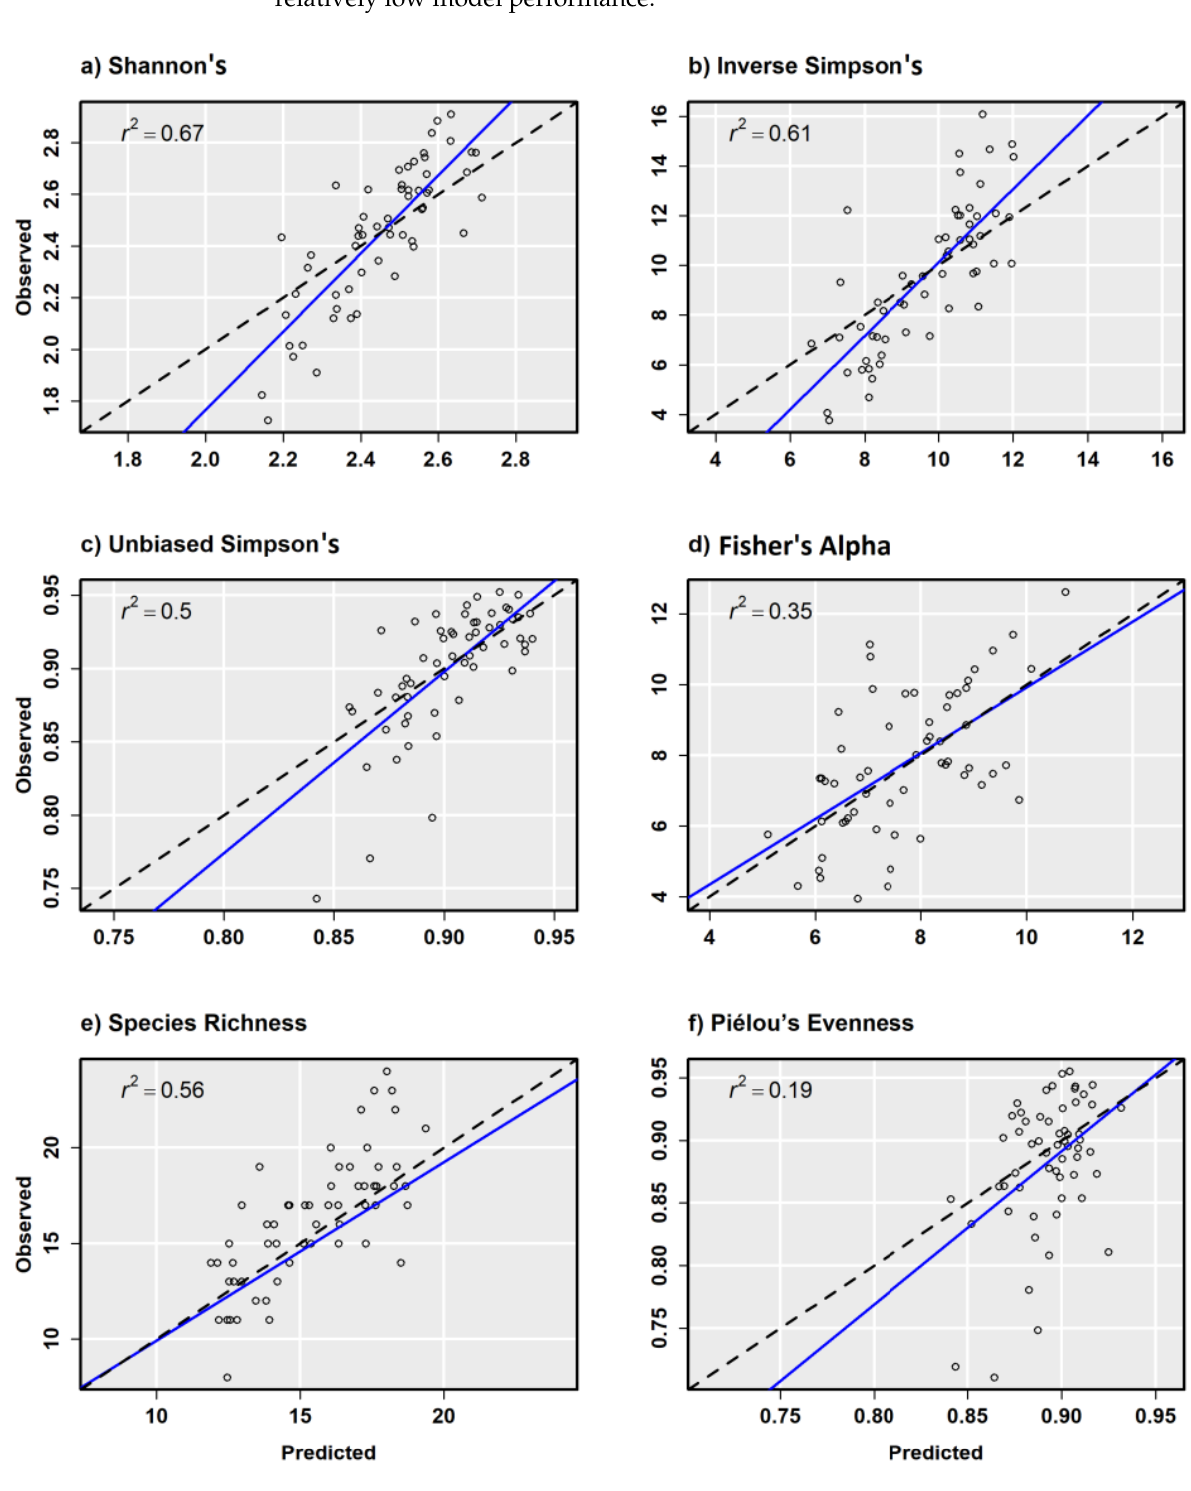
Figure 6. Observed versus predicted diversity index values for 0.10 ha random validation plots from the combined ensemble models using Sentienl-2, RapidEye, and canopy height and topography predictor variables.